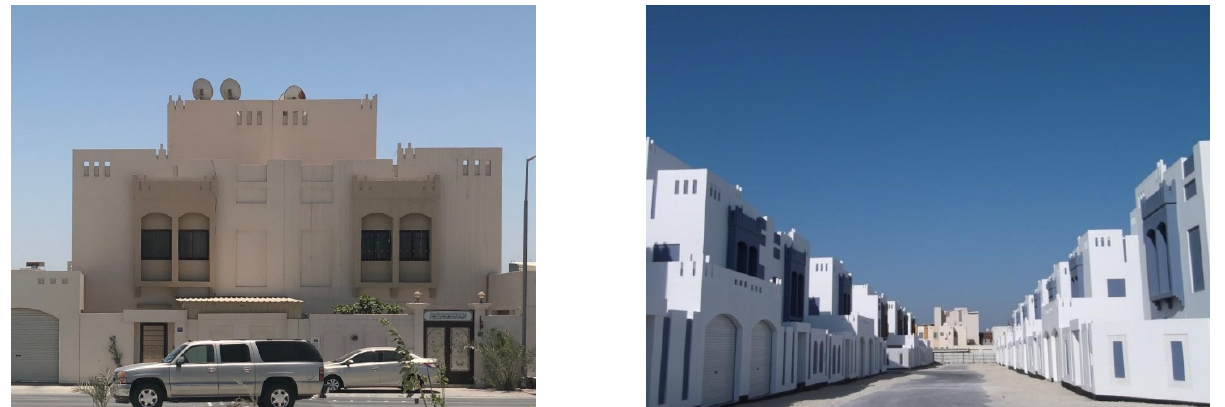
Figure 2. T3M residential unit as a reference case study.